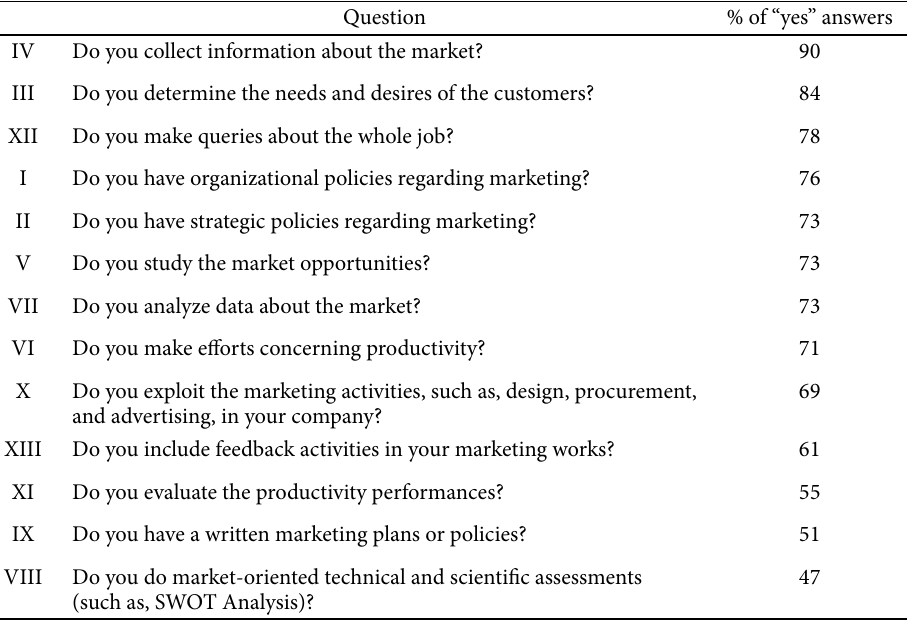
Table 3. Questionnaire about the Marketing Activities Conducted Within a Company